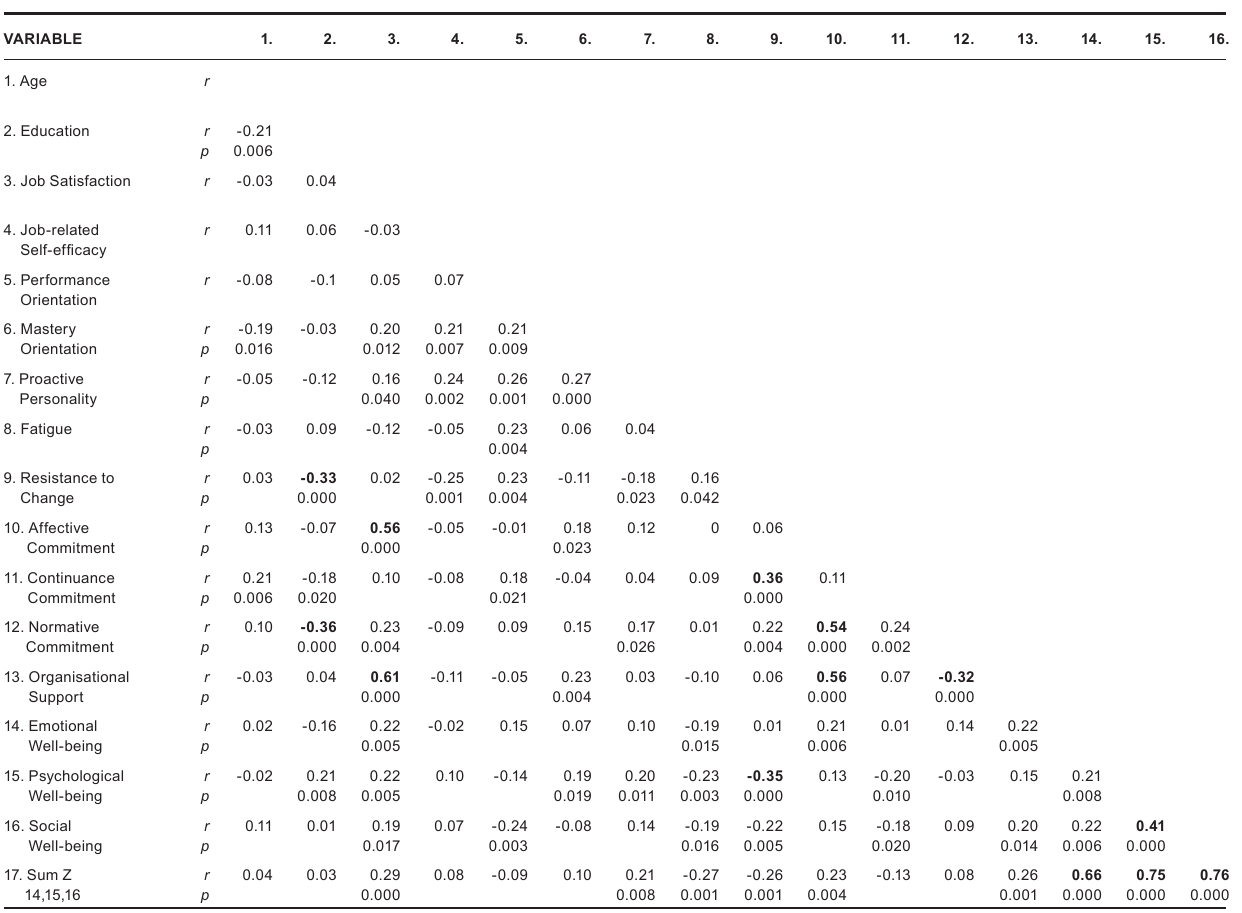
TABLE 2 Intercorrelations of all variables, with levels of statistical and practical significance